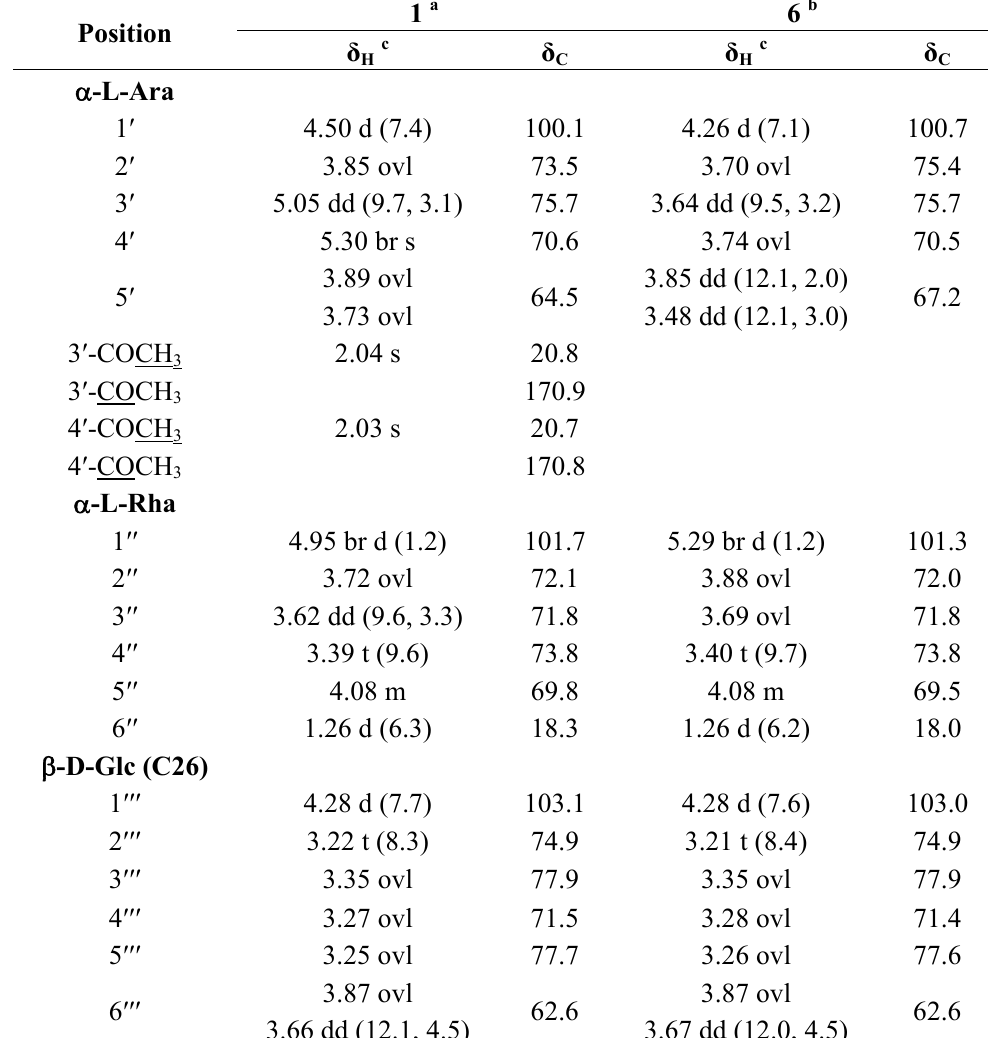
Table 2. 1 H- and 13 C-NMR data (CD compounds 1 and 6